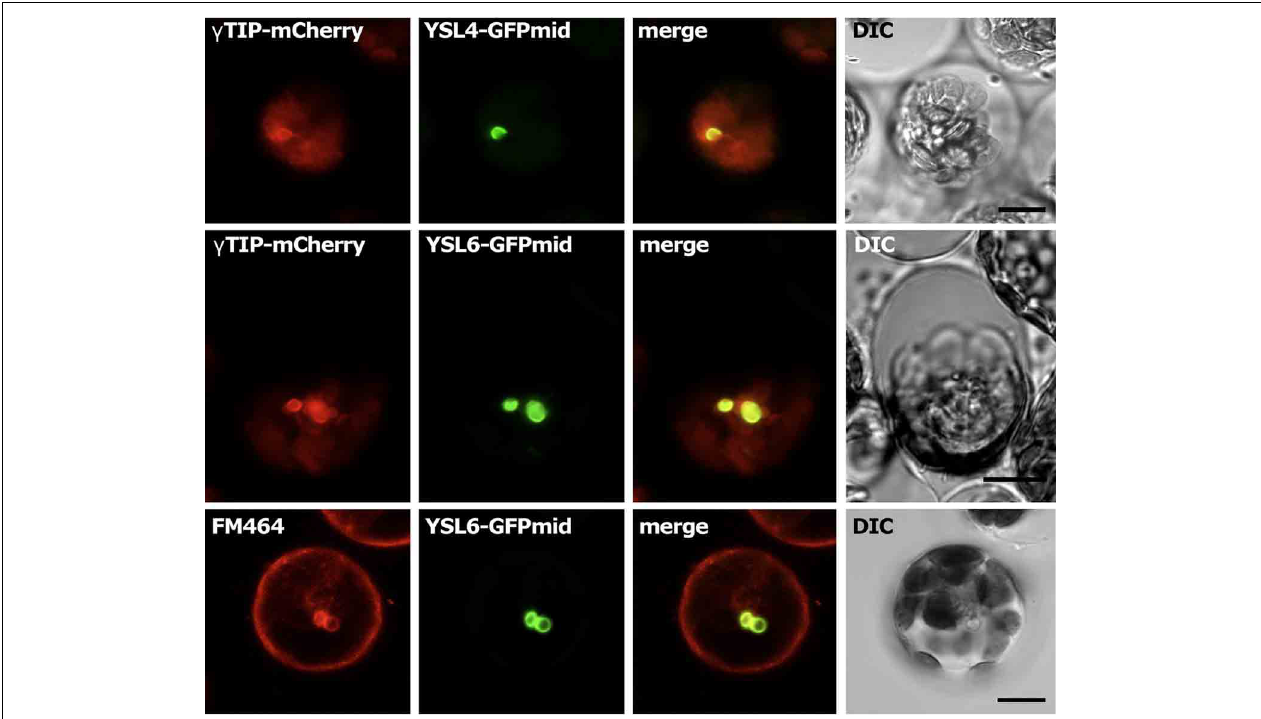
FIGURE 4 | Subcellular localization of AtYSL4 and AtYSL6 in protoplasts. Each horizontal row of four images shows (left to right) red fluorescence, green fluorescence, merged red and green images, and differential interference contrast. Top row: protoplast co-transformed with